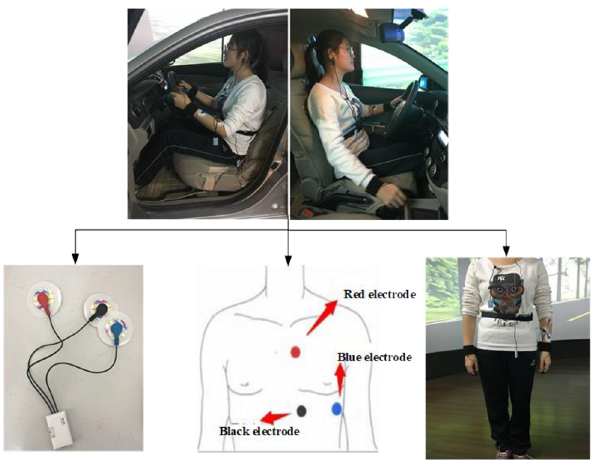
Figure 6 The wearable wireless ECG sensors Figure 7 The simulation-based experiment route and street view